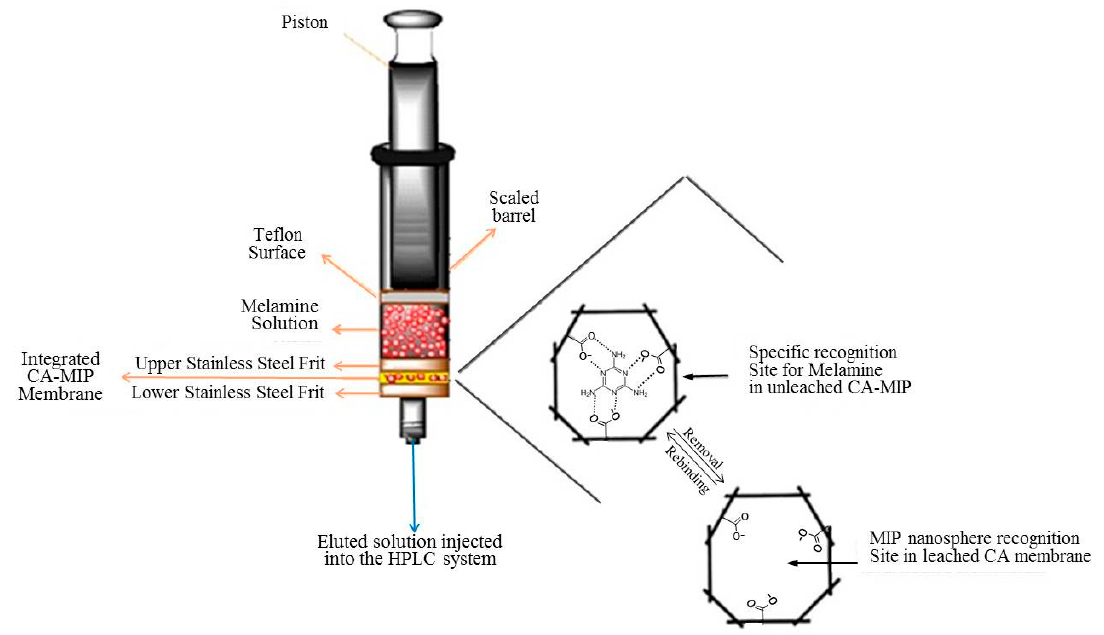
Figure 9. Schematic representation of recognition sites and extraction of melamine by photografted polymers in CA membrane network. Reproduced with permission from [43].